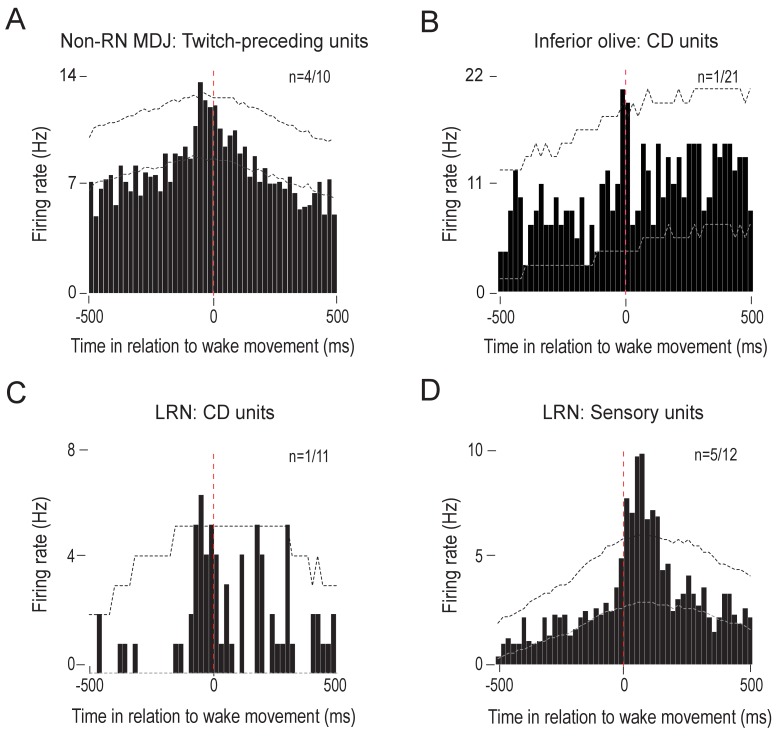
Neural activity in relation to wake-movement onset.(A) Perievent histogram showing non-RN MDJ unit activity in relation to wake-movement onset.Data are pooled across the 4 units (out of a total of 10 twitch-preceding units) that showed significant increases in activity 10–100 ms before wake movement onset (triggered on 331 wake movements). In this and the other panels, upper and lower confidence bands (p < 0.05 for each band) are indicated by horizontal dashed lines. (B) Perievent histogram showing IO unit activity in relation to wake-movement onset. The data are from the 1 unit (out of a total of 21 twitch-related CD units) that showed a significant increase in activity within ±10 ms of wake-movement onset (triggered on 33 wake movements). (C) Perievent histogram showing LRN unit activity in relation to wake-movement onset. Data are from the 1 unit (out of a total of 11 twitch-related CD units) that showed a significant increase in activity within ±10 ms of wake-movement onset (triggered on 45 wake movements). (D) Perievent histogram showing LRN unit activity in relation to wake-movement onset. Data are pooled across the 5 units (out of a total of 12 sensory units) that showed significant increases in activity >10 ms after twitch onset (triggered on 364 wake movements).10.7554/eLife.38213.014Figure 5—figure supplement 1—source data 1.Source data for panels A-D.